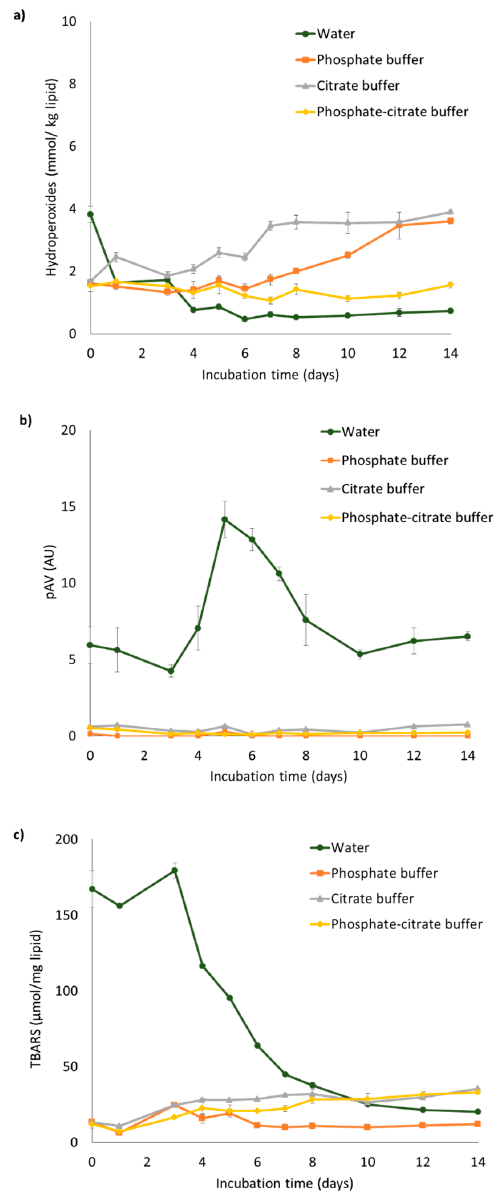
Figure 3. ( a ) Hydroperoxide concentration, ( b ) para-anisidine value (pAV), and ( c ) TBARS concen- tration in liposome suspensions prepared in water, phosphate, citrate, or phosphate-citrate buffer, with 0.2 mM ferrous sulfate. All liposome suspensions were incubated at 40 ◦ C under slow rotative agitation. Error bars represent standard deviations (n = 4).